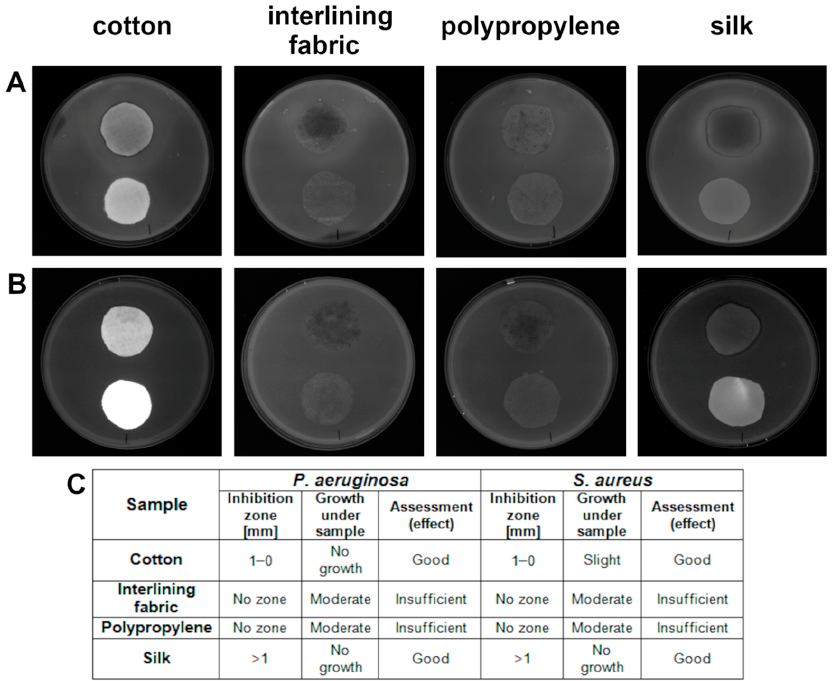
Figure 6. Antibacterial activity of textile materials against: ( A ) P. aeruginosa ; ( B ) S. aureus ; ( C ) evaluation according to ISO 20645:2004. Within each plate shown, implants placed closer to the upper edge of each plate are treated with nanomaterials and implants placed closer to the lower edge of each plate are control textiles.